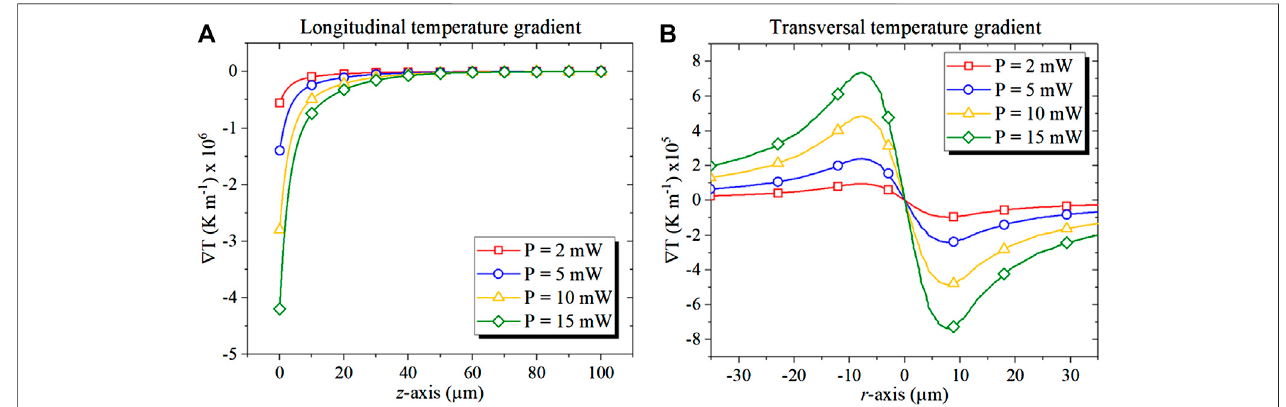
FIGURE 7 | (A) Longitudinal gradient temperature pro fi le along the propagation axis z and (B) transversal gradient temperature pro fi le obtained at zHT ∼ 75.4 µm, for 2, 5, 10, and 15 mW obtained through simulation in COMSOL Multiphysics.